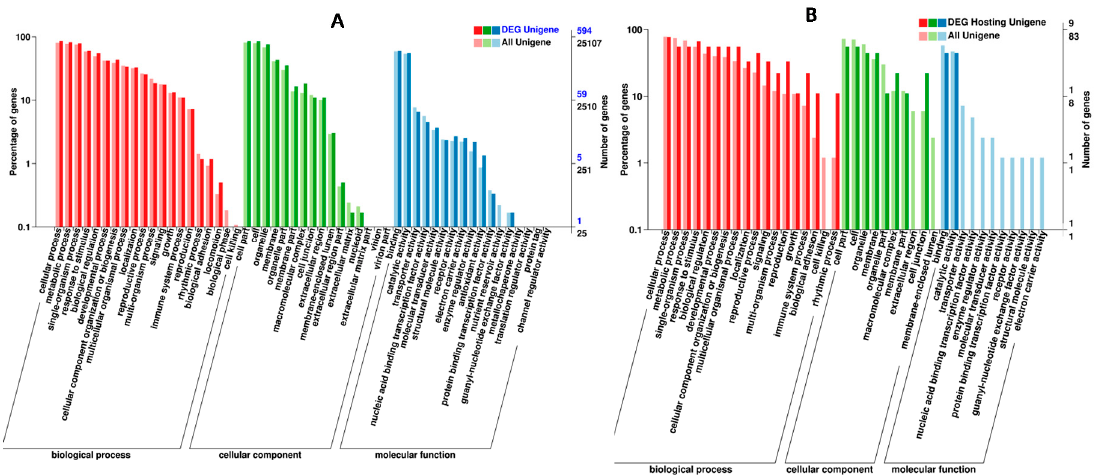
Figure 3. The gene ontology (GO) and Kyoto encyclopedia of genes and genomes (KEGG) analysis of the ncRNAs targets indicated that several important enzymes were involved in the chilling injury (CI).